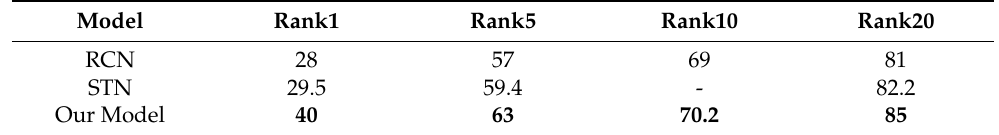
Table 7. Model Accuracy Using a